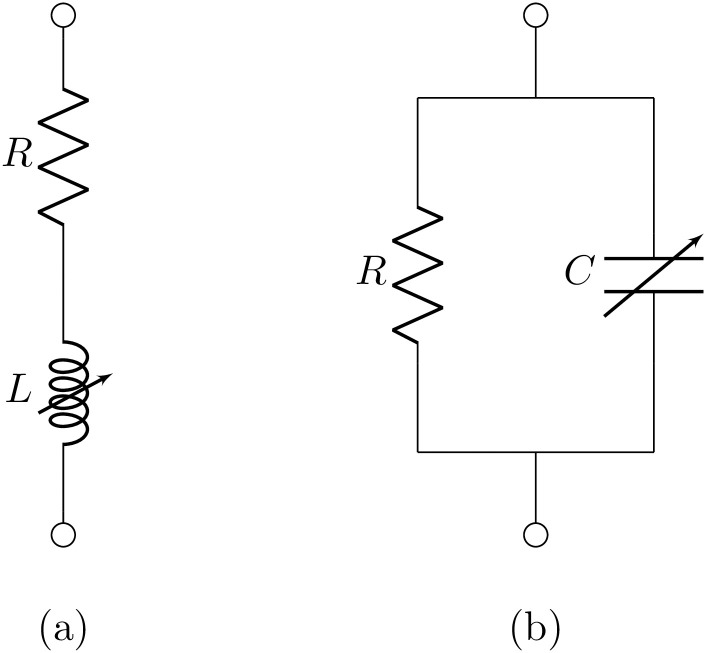
Equivalents to capactive and inductive CPEs.Equivalent circuit for a capacitive Constant Phase Element (a) and an inductive Constant Phase Element (b). Inductance and capacitance respectively increase linearly with time.